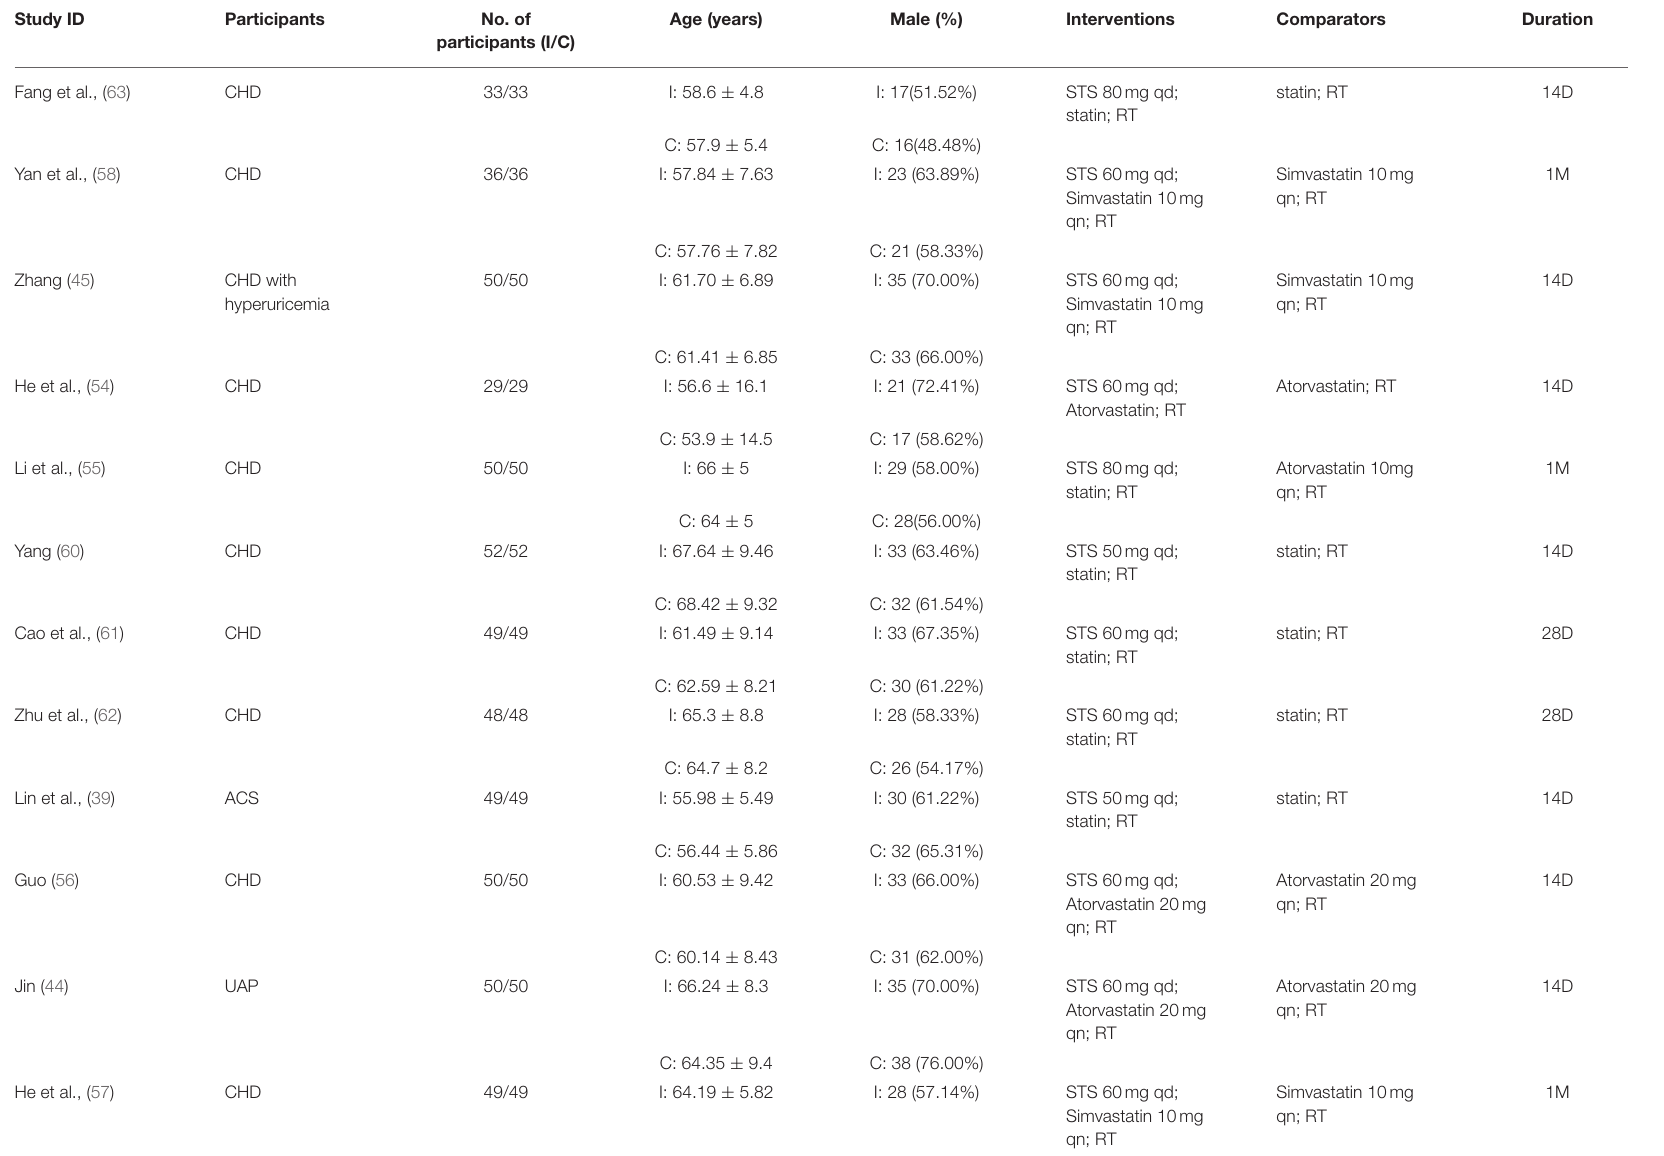
TABLE 1 | Characteristics of the included RCTs and the detail of